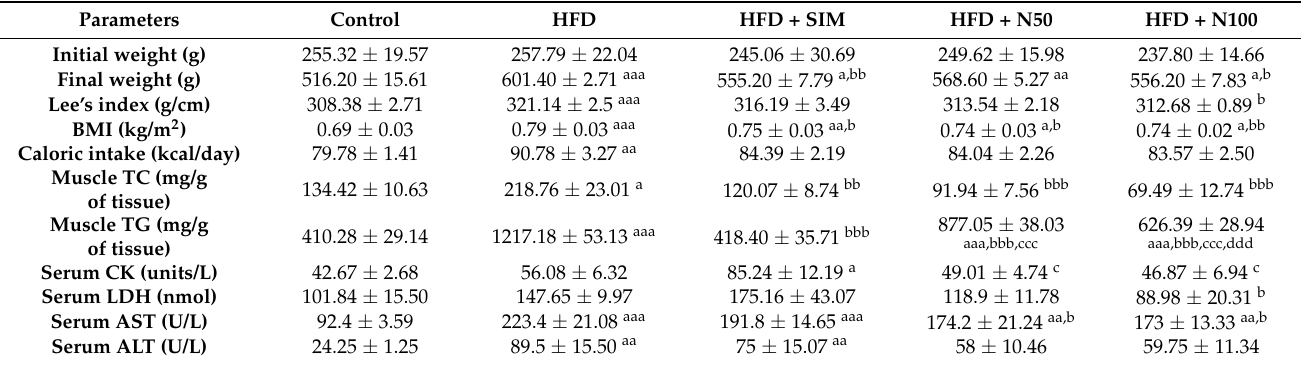
Table 3. The effects of naringin on food intake, body weight, Lee’s index, BMI, %adiposity index, and biochemistry parameter levels in high-fat-diet-fed